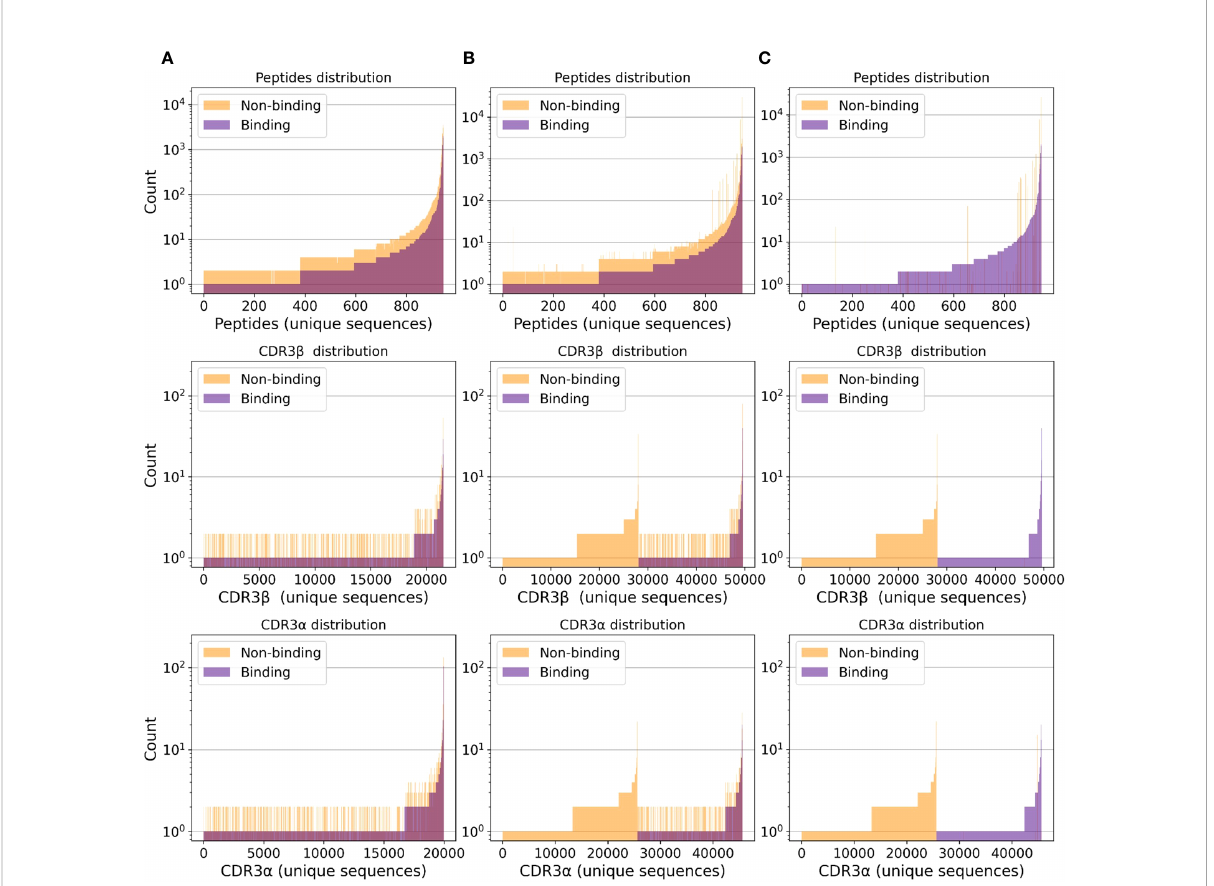
FIGURE 1 Separate class distributions for unique peptides ( fi rst row), CDR3 b (second row), and CDR3 a (third row) sequences in all ( peptide, CDR3 b , CDR3 a ) samples. A point on the x -axis represents one unique sequence of amino acids. The y -axis represents how frequently a given peptide, CDR3 b , or CDR3 a sequence appears in the considered samples. Sequences are sorted by count. (A) Negative samples only include randomized data points (i.e., no negative assays). (B) Negative samples include negative assays and randomized negative samples. (C) Negative samples only include negative